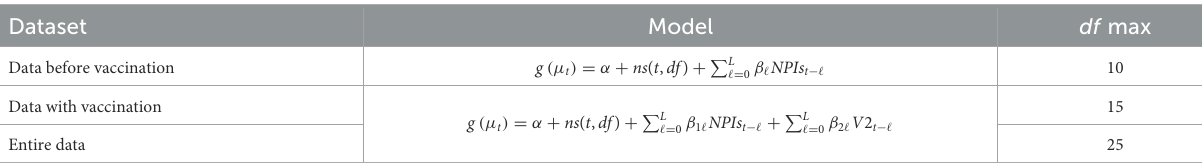
TABLE 1 Summary of model features. df max is the maximum degree of freedom